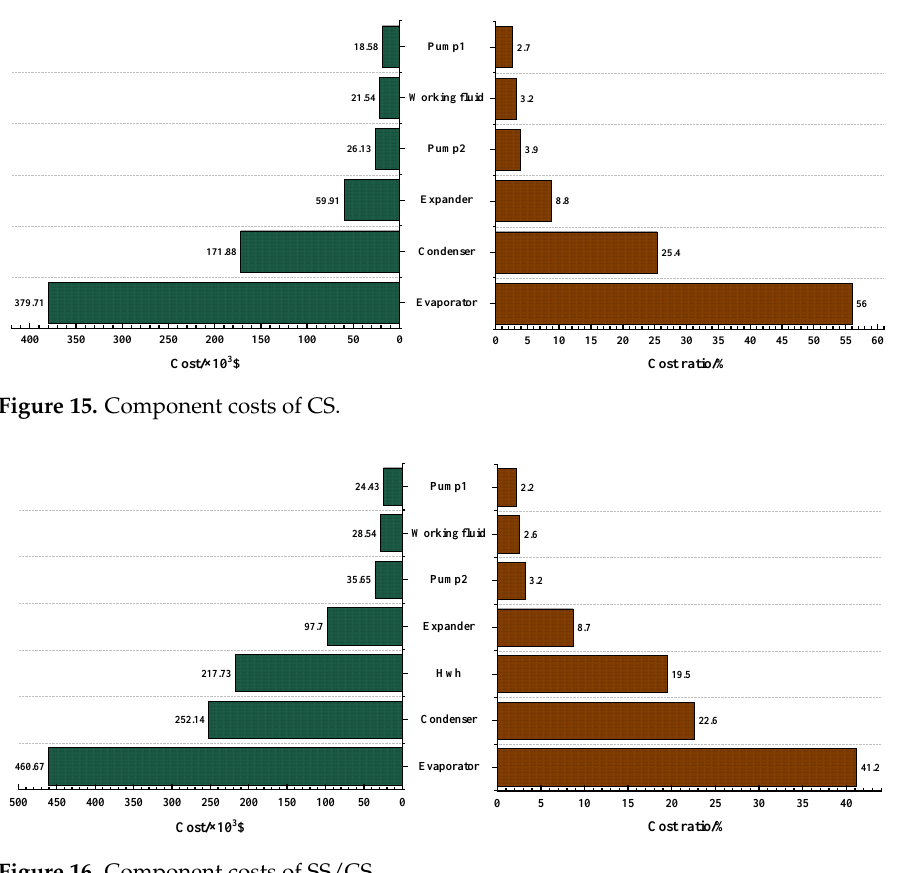
Figure 16. Component costs of SS/CS.